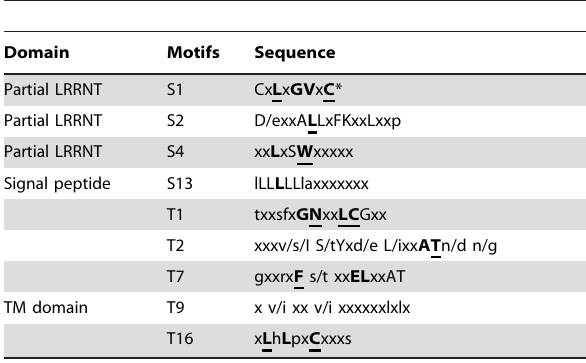
Table 2. Major motifs in signal peptide and transmembrane region within rice